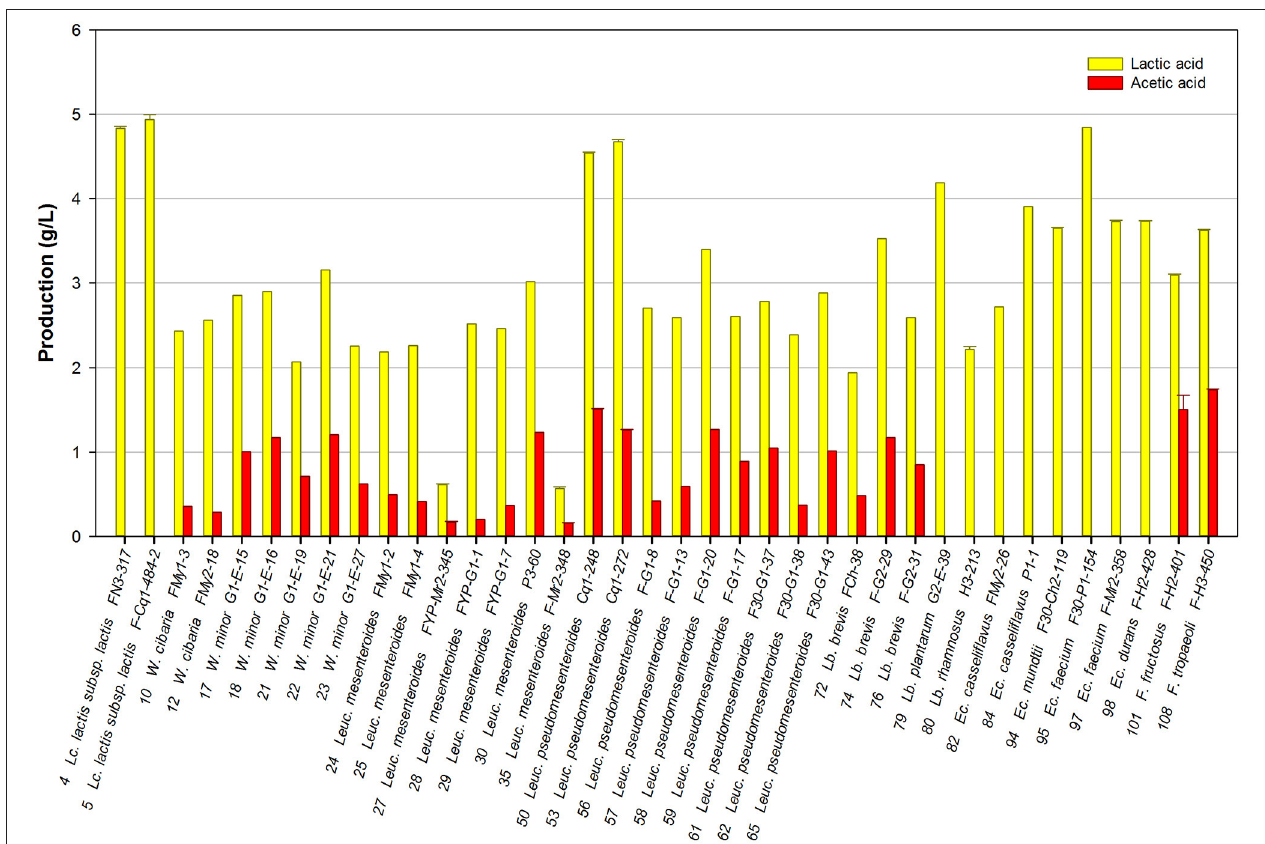
FIGURE 1 | Lactic acid and acetic acid production by selected LAB grown in FSM at 30 ◦ C for 24 h.